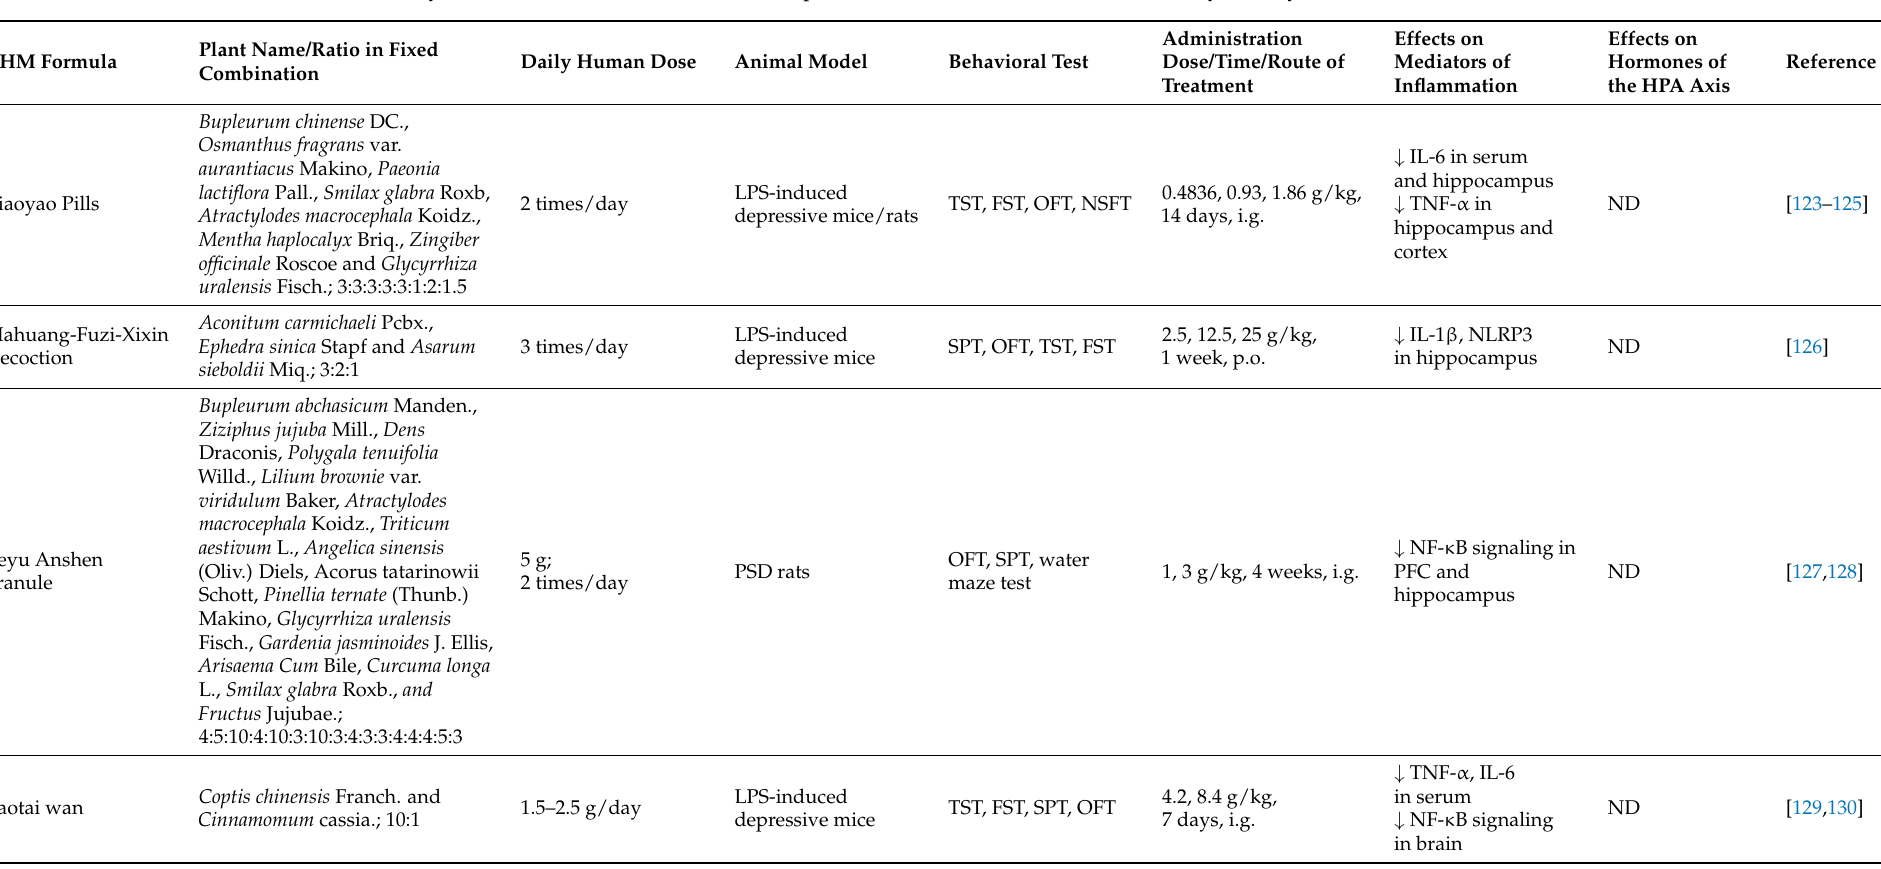
Table 2. CHM formulas traditionally used in TCM for the treatment of depression, which exhibit anti-inflammatory activity and modulate the release of HPA axis hormones. CHM